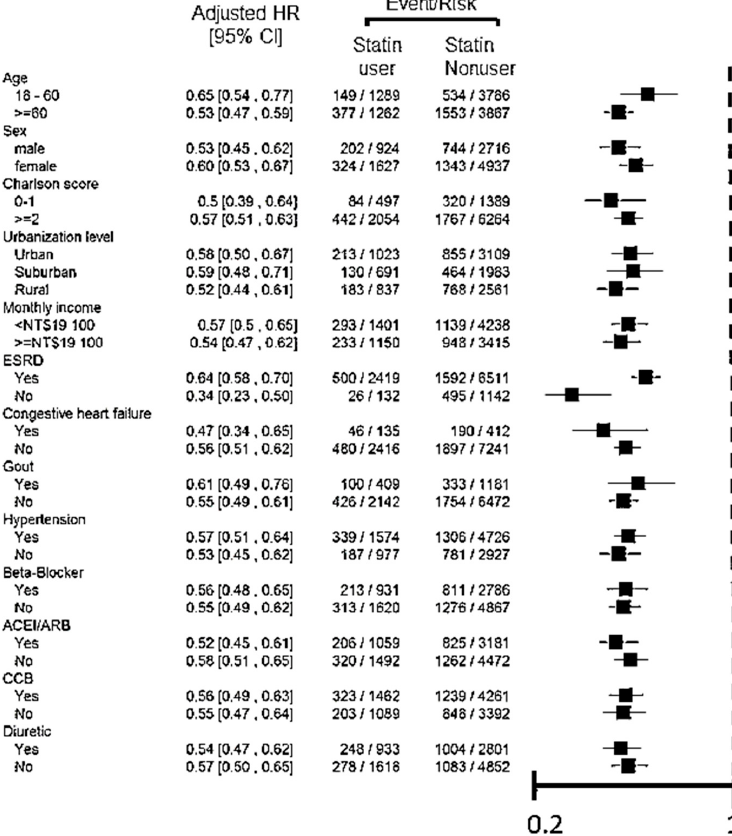
Figure 2. The adjusted hazard ratio for statin use versus nonuse in advanced chronic kidney disease patients on the incidence of all-cause mortality after propensity score matching, stratified by comorbidities. (ESRD, end-stage renal disease denoted who received subsequent chronic dialysis). Abbreviations: HR, harzard ratio; ACEI, angiotensin-converting-enzyme inhibitors; ARB, Angiotensin II receptor blockers; CCB, calcium-channel blocker.